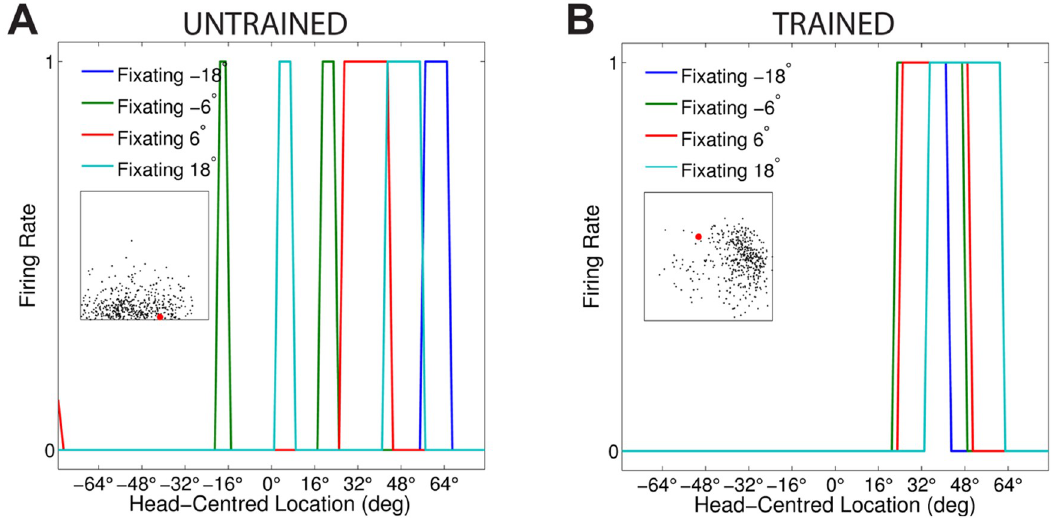
Fig 21. Simulation results showing the firing rate responses of a model incorporating a population of monotonic modulated input neurons trained with the modified learning rule 20: Delayed postsynaptic trace learning rule. The figure shows the firing rate responses of output neuron #223 before training (A) and after training (B) during testing for four different eye-positions: − 18˚, − 6˚, 6˚ and 18˚. Conventions as for Fig 12. The comparison of subplot (A) and subplot (B) shows that the output neuron learned to respond to a specific head-centred location regardless of the eye-position after training. Output neuron #223 is not shown in the scatter plot of subplot (A) because this neuron did not respond for every eye-position before training and was therefore excluded from further analysis (section Analysis of Network Performance). However, subplot (B) shows that the same output neuron learned to respond to a specific head-centred location regardless of the eye-position after